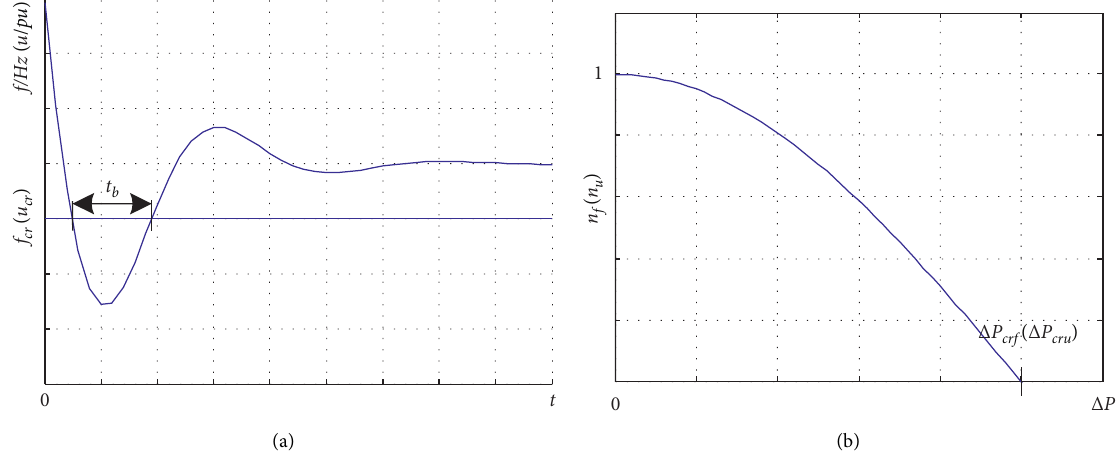
Figure 7: Node transient frequency offset security diagram.